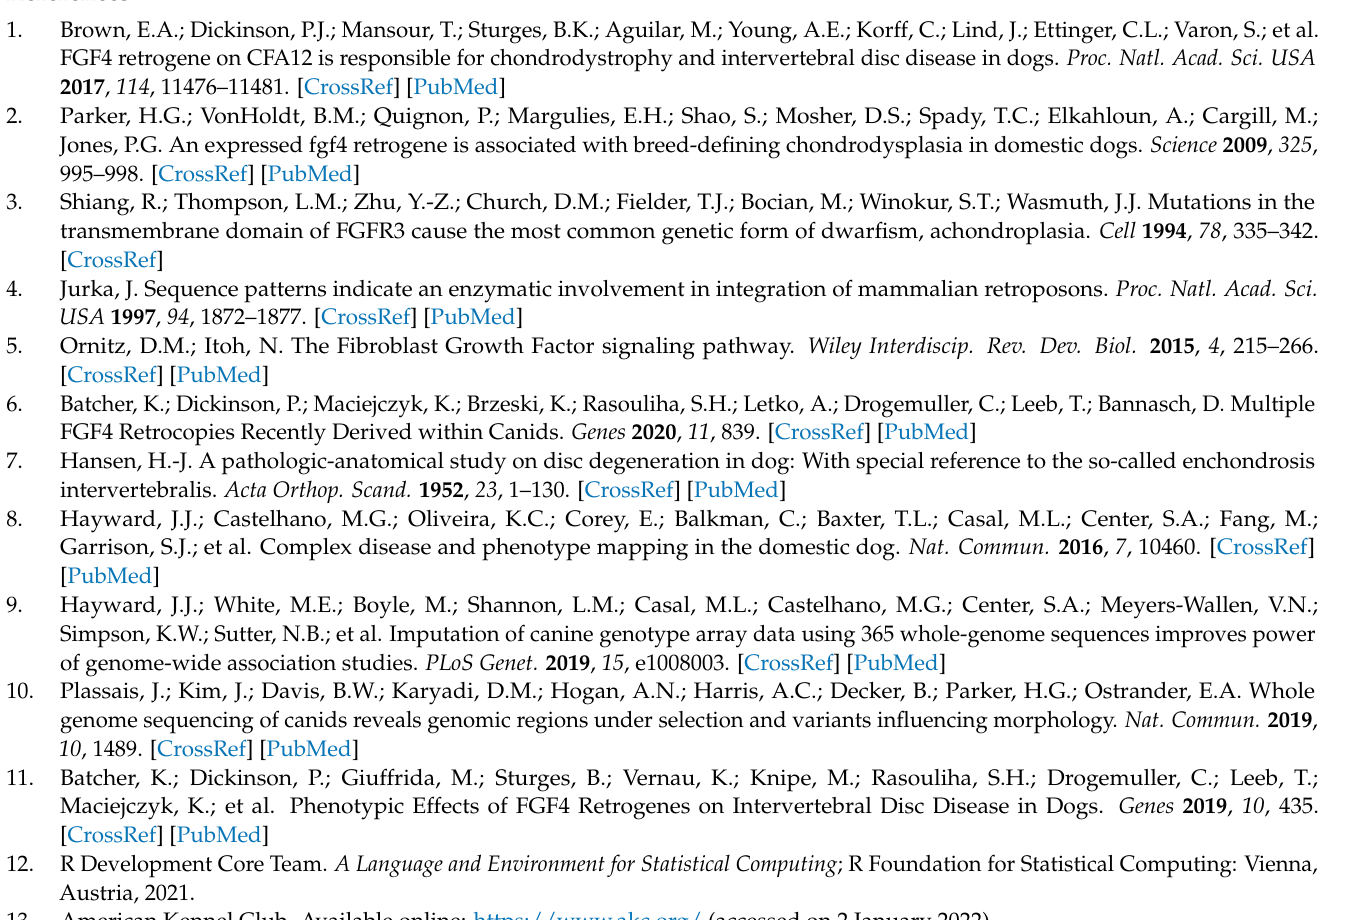
bracke, Table S5. Univariable and multivariable analysis of individuals measurements from the Schweizer